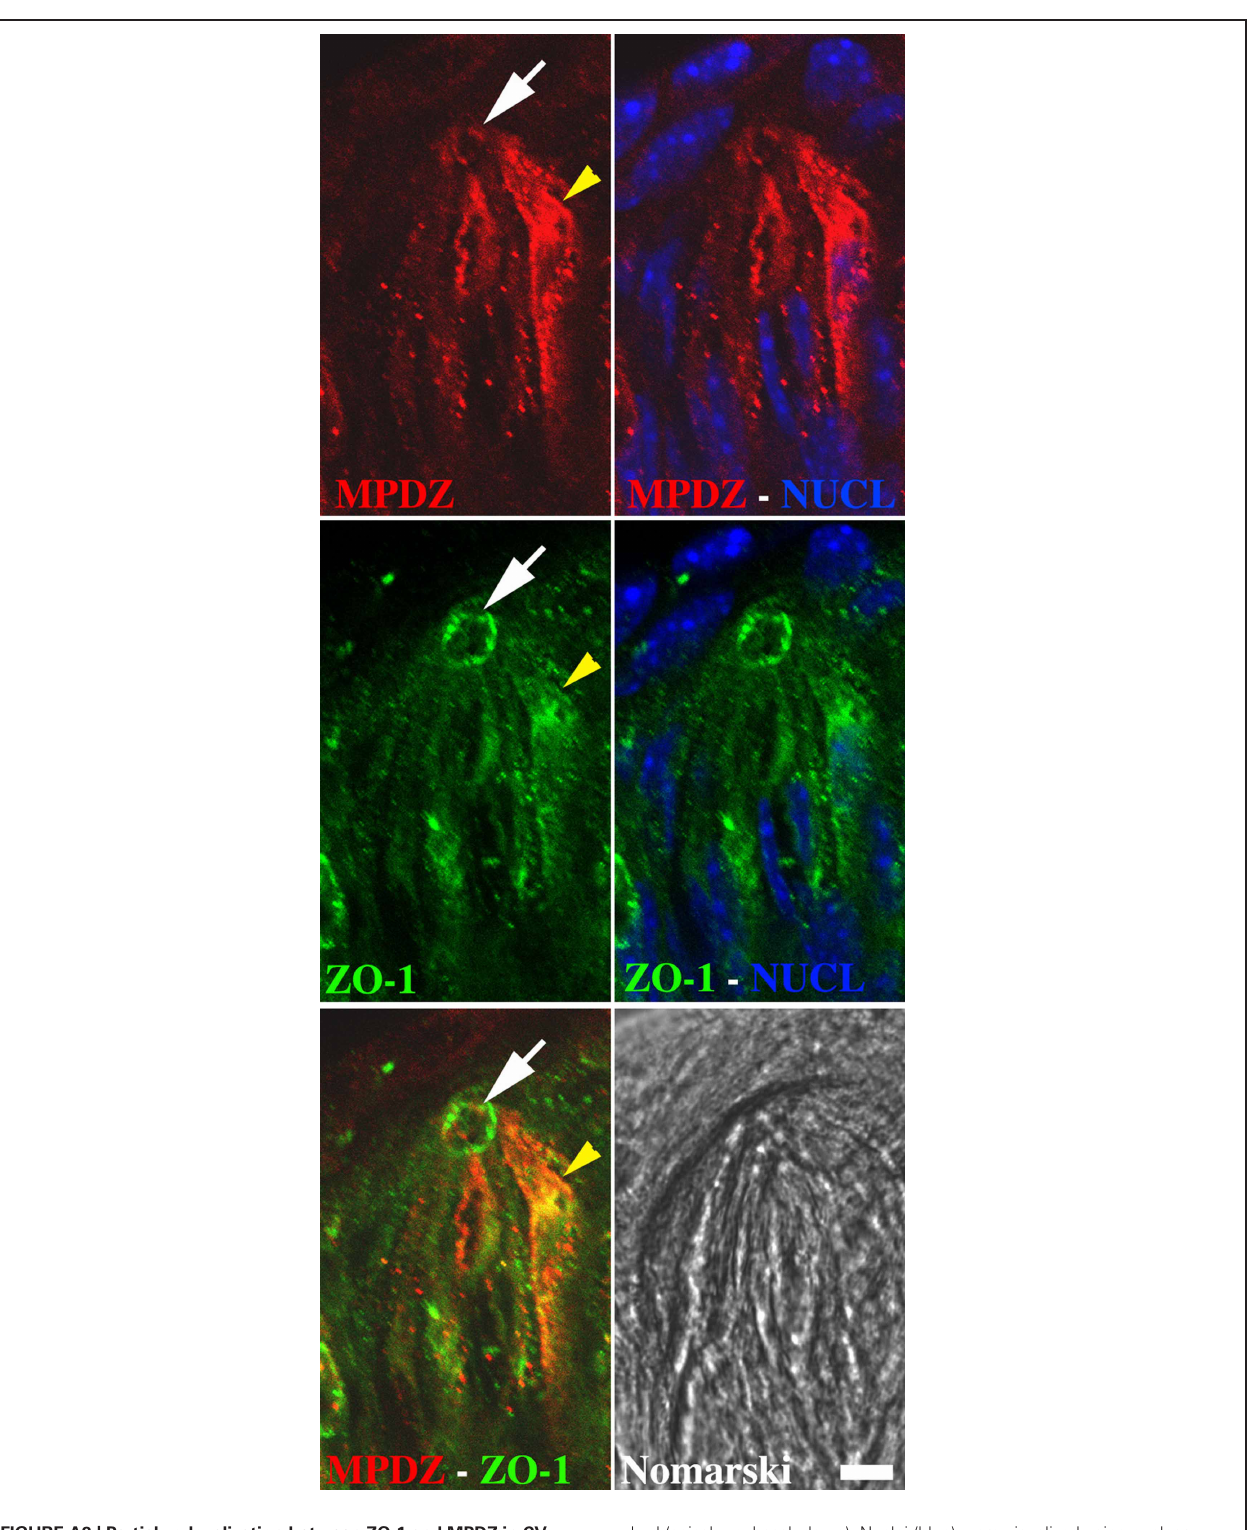
FIGURE A2 | Partial co-localization between ZO-1 and MPDZ in CV taste bud cells. Immunolocalization of MPDZ (red) and ZO-1 (green) in circumvallate taste buds. Indirect immunofluorescence on saggital cryosections of circumvallate papillae was performed as described under Section “Immunohistochemistry.” Each image shows one entire taste